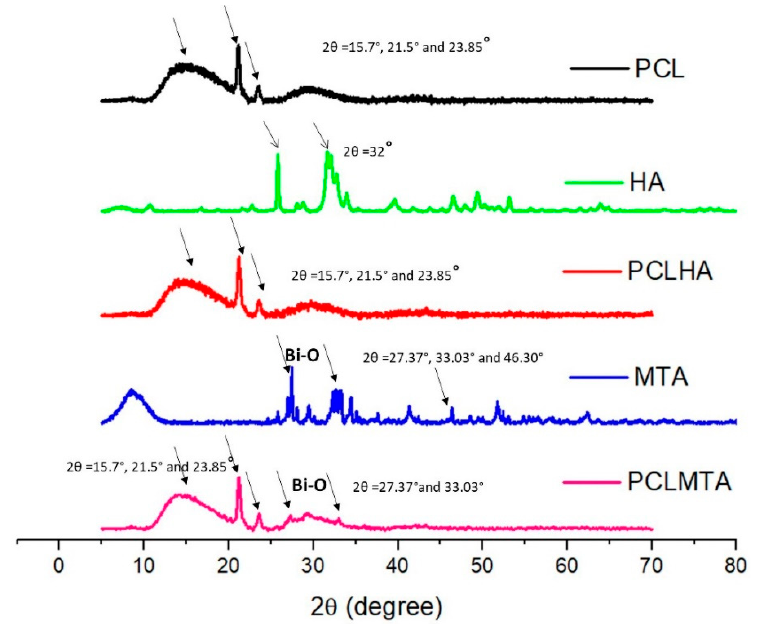
Figure 3. X-ray diffraction (XRD) pattern of PCL, HA, PCLHA, MTA, and PCLMTA. The signature 2 θ value of the respective material is represented by arrows in the diffractogram.